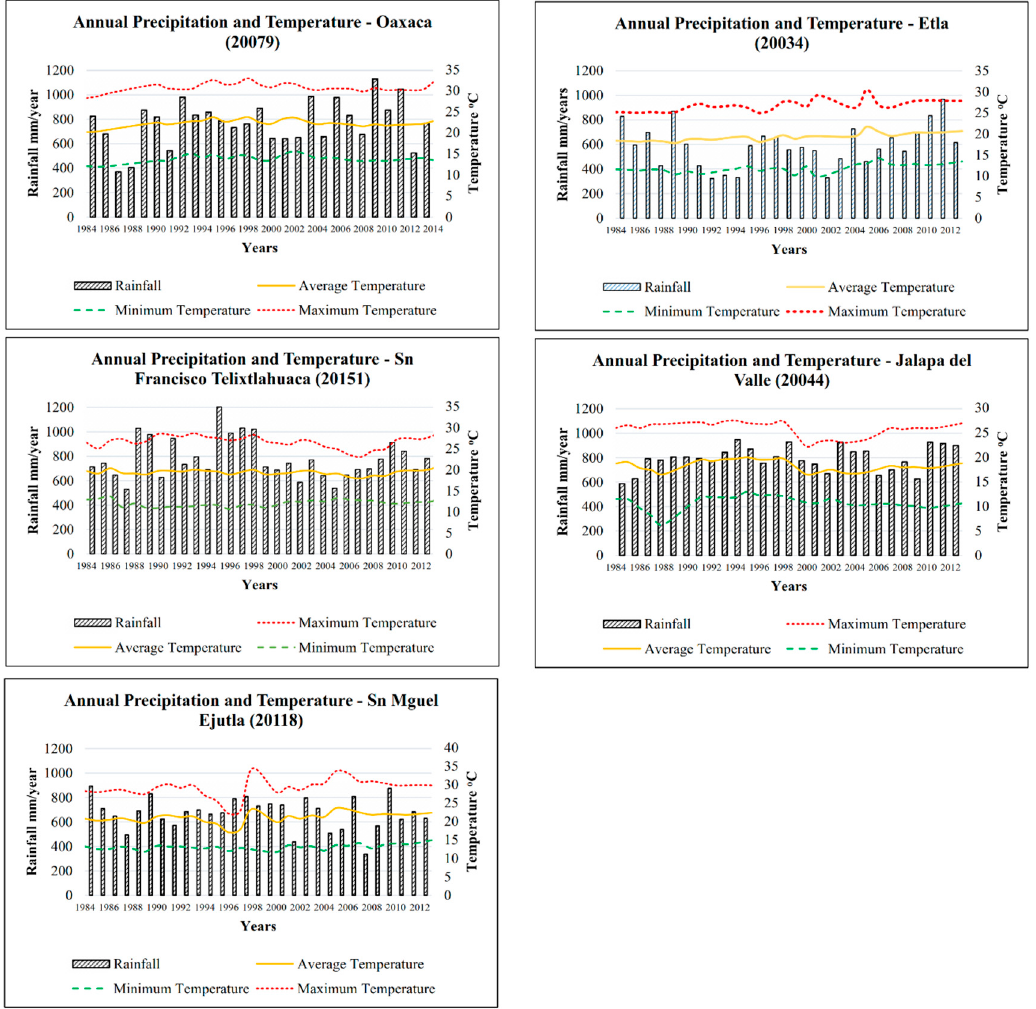
Figure 3. Climographs of five meteorological stations in the study area. Table 1. Statistic values of the meteorological stations